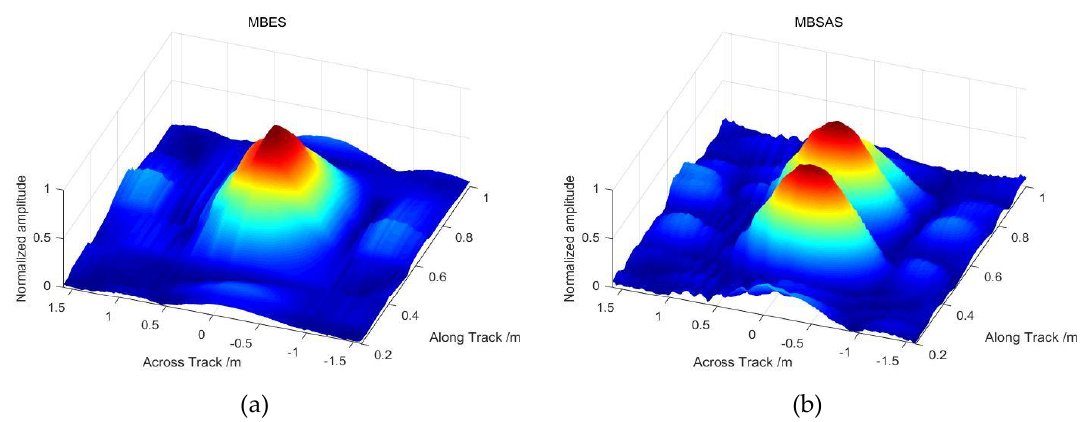
Figure 16. Comparison of imaging algorithms: dual ball imaging slice of ( a ) MBES and ( b ) MBSAS.